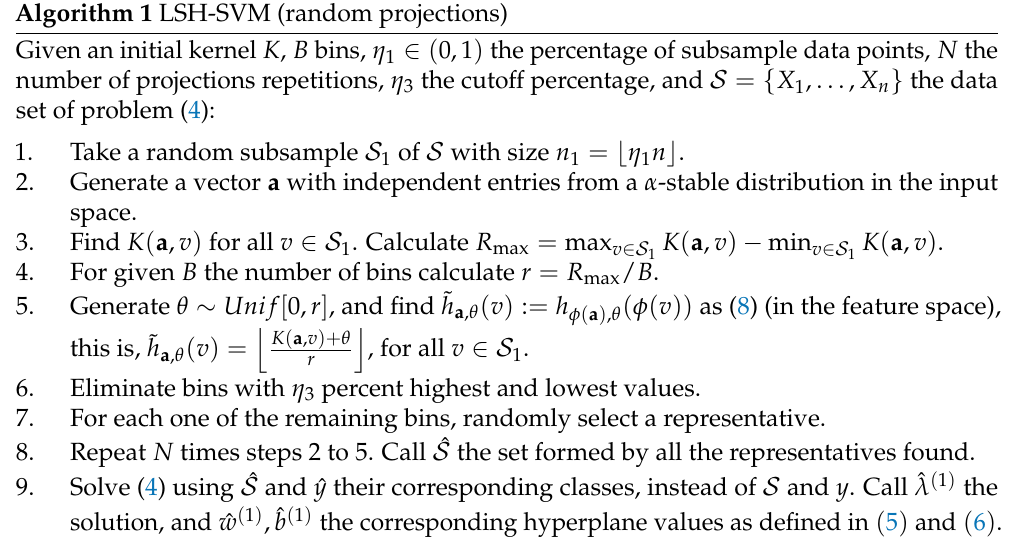
Algorithm 1 LSH-SVM (random projections)